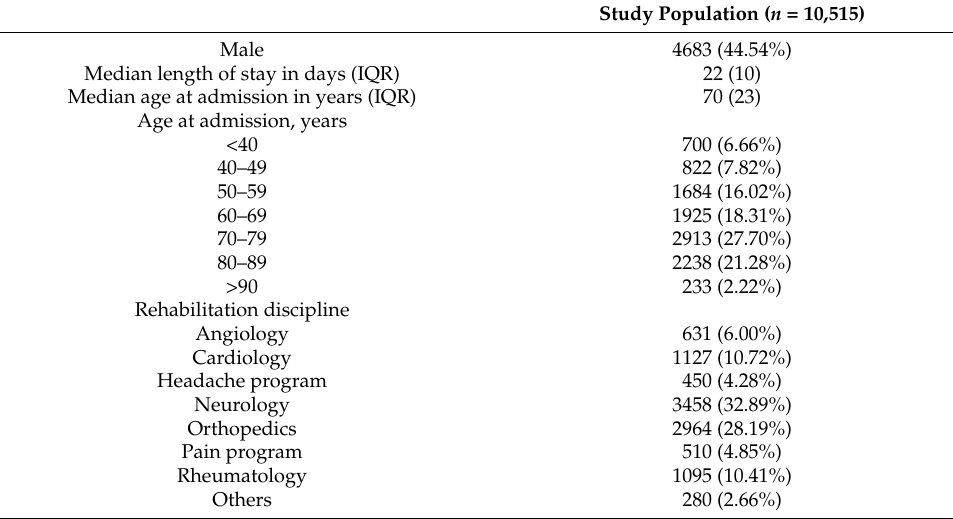
Table 2. Baseline characteristics of the study